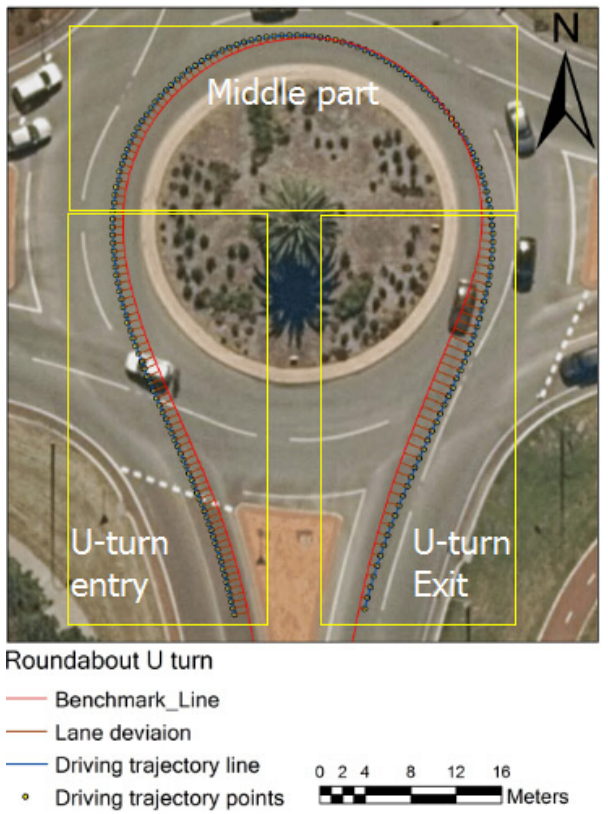
Figure 1. Driving trajectory and lane deviation from benchmark line in a U-turn and the three sections of the U-turn.